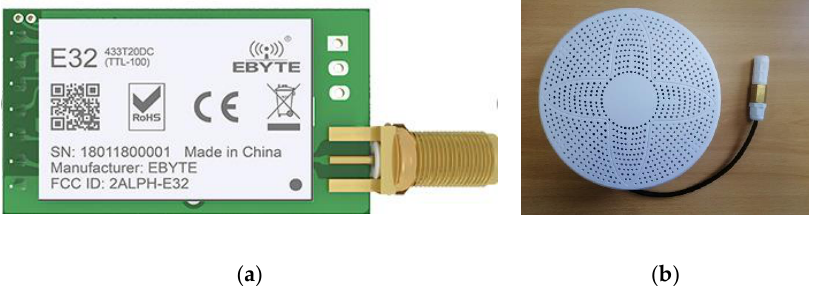
Figure 5. LoRa modules: ( a ) transmitter; ( b ) receiver.